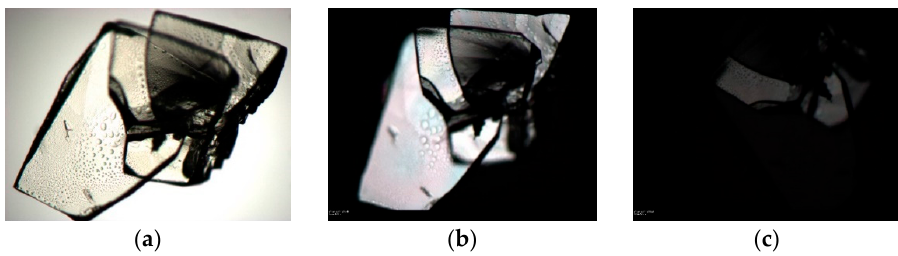
Figure 11. Photomicrographs of form III while looking under (a) unpolarized light and (b) polar- ized light on a circular microscope stage (c) Extinction of the crystal is observed at the optimum light on a circular microscope stage ( c ) Extinction of the crystal is observed at the optimum angle to angle to display maximum birefringence. display maximum birefringence.